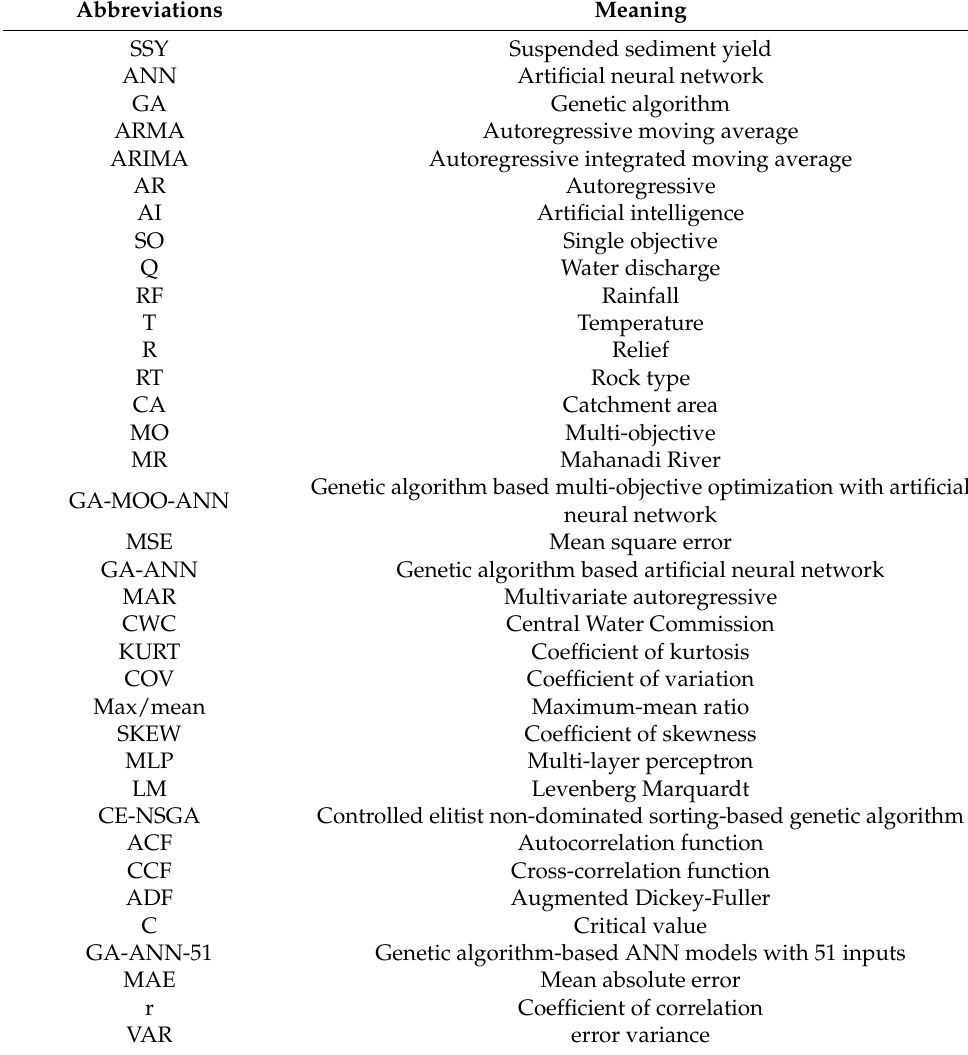
Table 1. List of abbreviations with